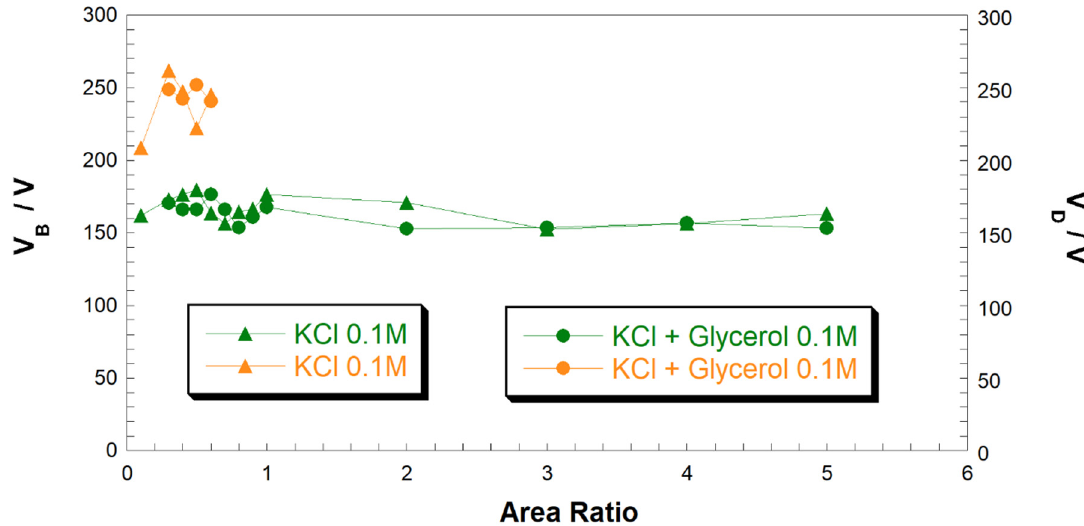
Figure 7. Breakdown voltage, V B (in green) and discharge voltage, V D (in orange) as a function of the ratio of the cathode-to-anode-immersed areas, with 0.1 M KCl in water (triangles) and glycerol/water mixture (circles).